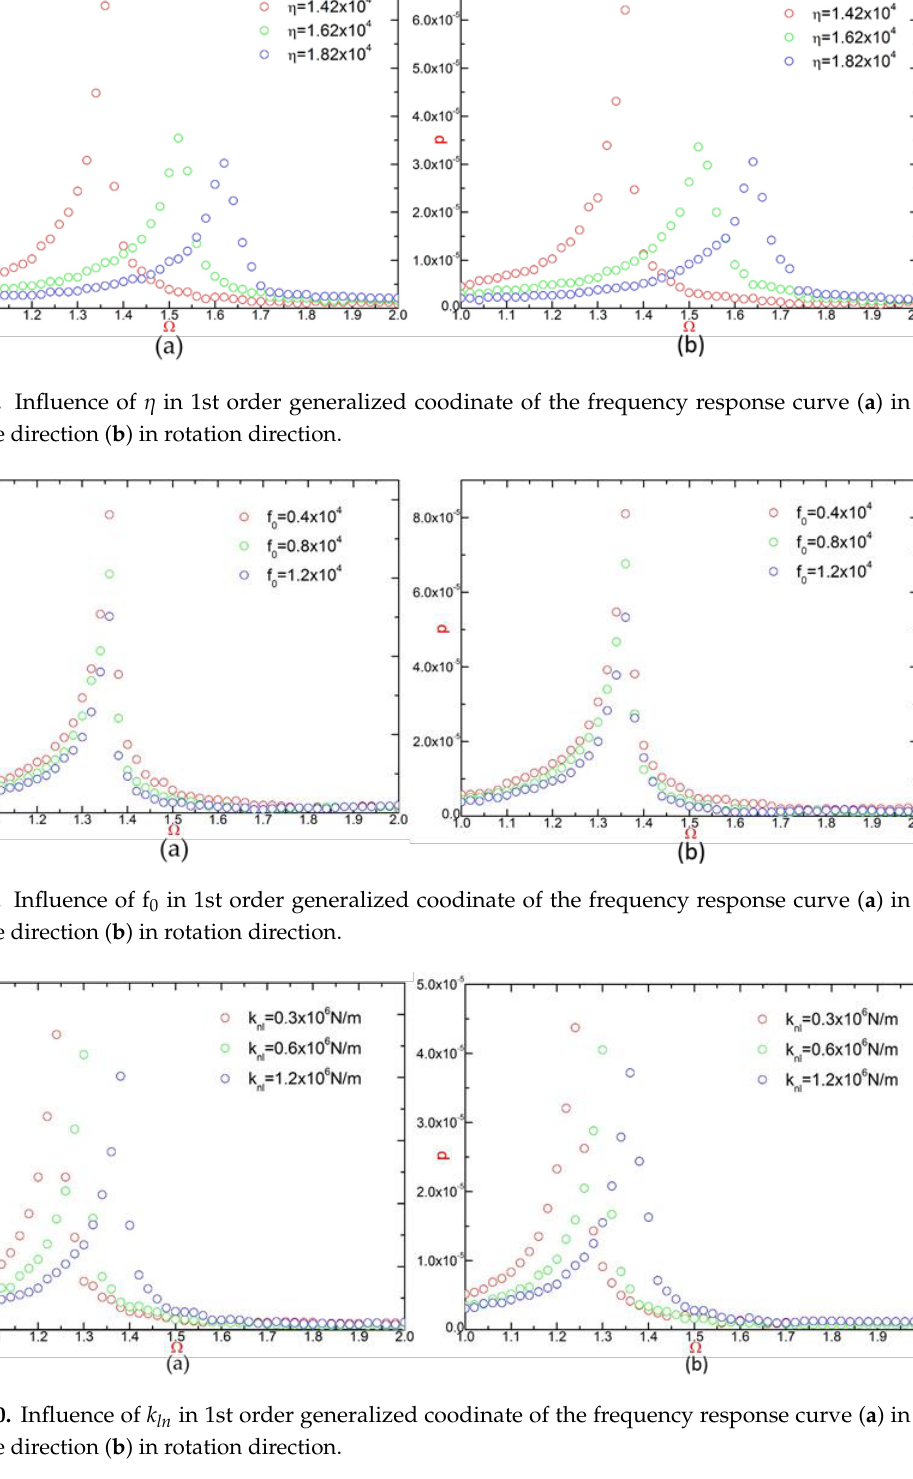
k in 1st order generalized coodinate of the frequency response curve (a) in Figure 10. Influence of ln transvese direction (b) in rotation direction. Figure 11a,b depict that in the first-order generalized coordinate system, as the value of dimensionless frequency  increases from 1 to 2, the generalized transverse coordinate values q and the generalized rotation coordinate values p formerly slowly upsurge to their respective resonance peaks, and then rapidly drop to near 0. All of them will expose a certain level of bifurcation. With the increase of